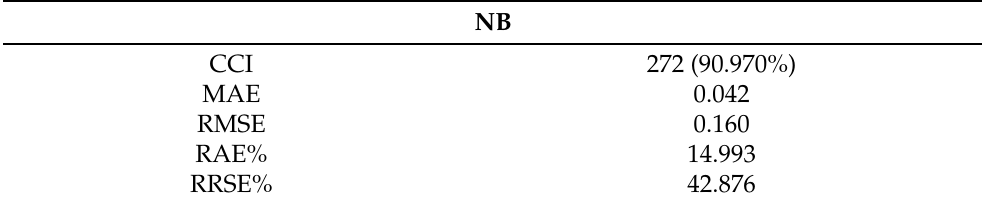
Table 9. CCI and Error Rates details achieved via NB.